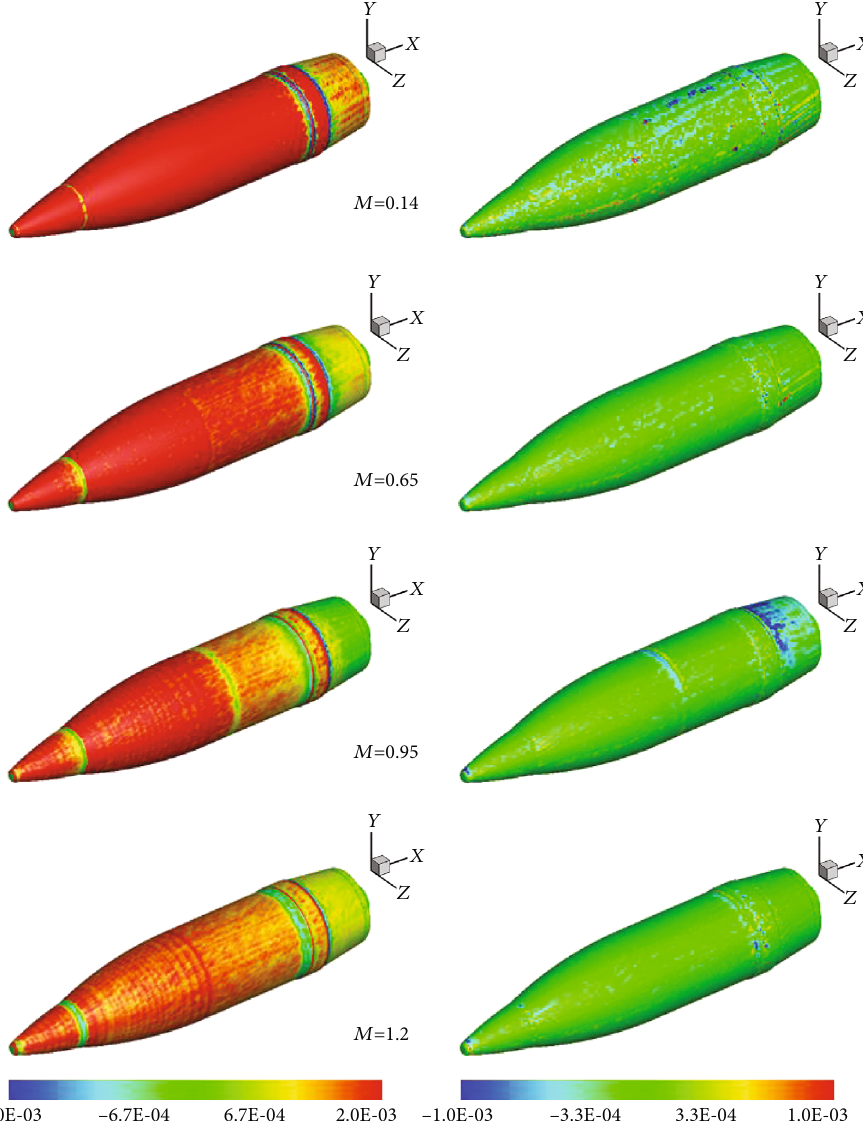
: 5 − C : 0 f α = 2 f α = 0